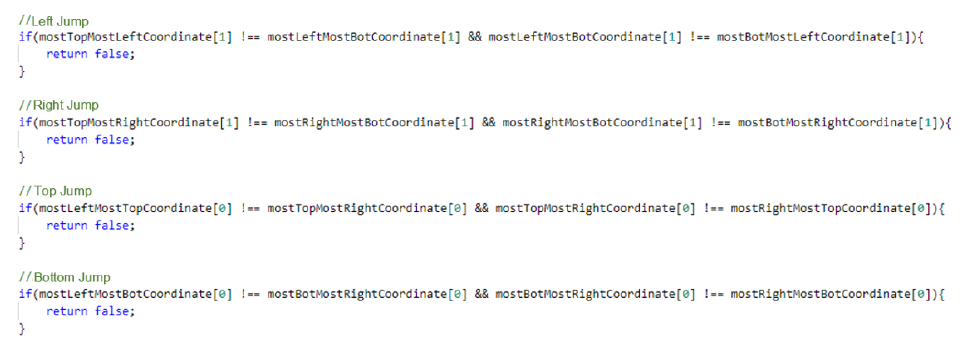
14 of 26 Figure 12. Space organization of an office block: inspection of internal jumps (staircase rule). This is followed by a search for external jumps. The coordinates of the office BU cor- responding to the representation that is required for the present examination are as fol- lows: 1. left and right coordinates of the top row; 2.